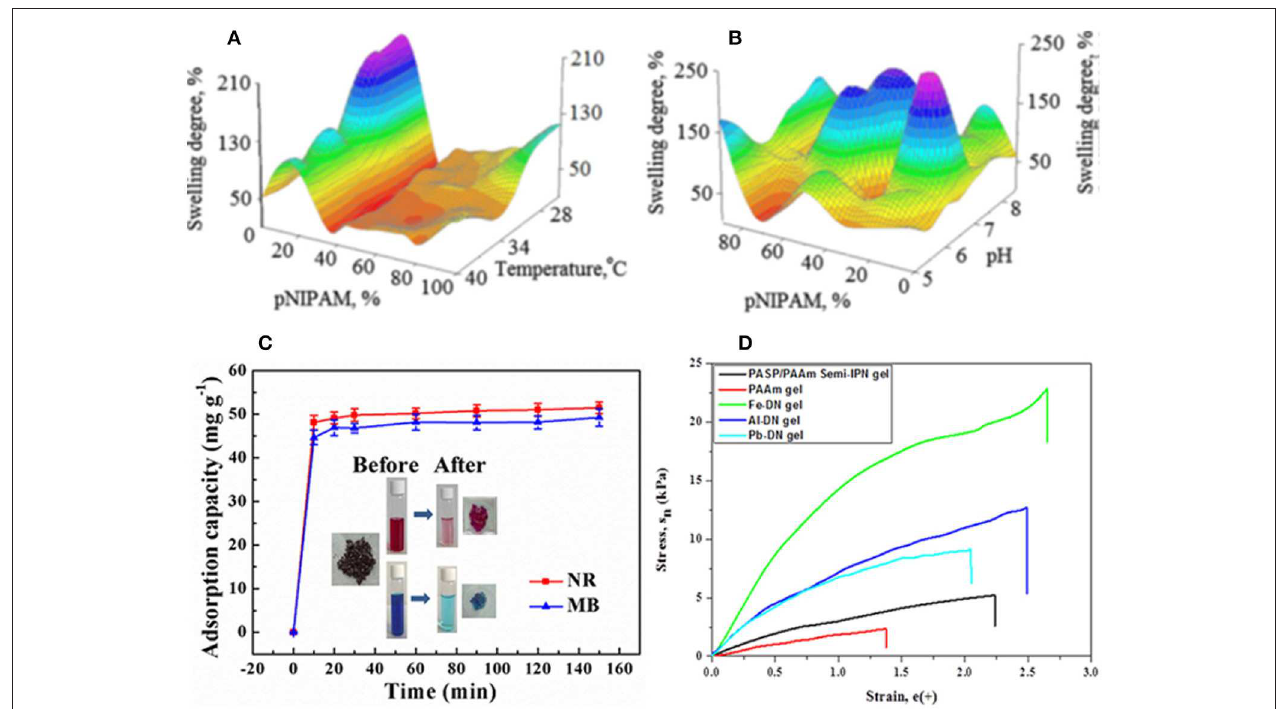
FIGURE 5 | Properties of IPN hydrogels based on PASP. (A,B) 3D swelling degree dependence on the network components and test parameters: (A) Temperature and (B) pH. Reproduced from Nistor et al. (2013) with permission from Wiley. (C) Adsorption capacity of methylene blue (MB) and neutral red (NR) by PASP/PAA semi-IPN hydrogels. Reproduced from Jv et al. (2019) with permission from American Chemical Society. (D) Stress-strain curve of double networks of PASP/PAAm hydrogels in the presence and absence of metallic cations. Reproduced from Lee et al. (2018) with permission from